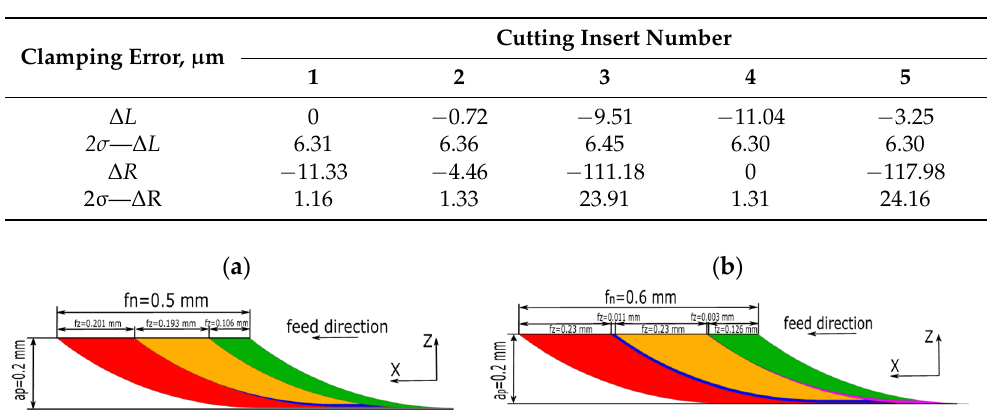
Table 3. Errors in clamping the cutting inserts in the body of the milling head and the number of teeth taking an active part in cutting for specified feed rate intervals.